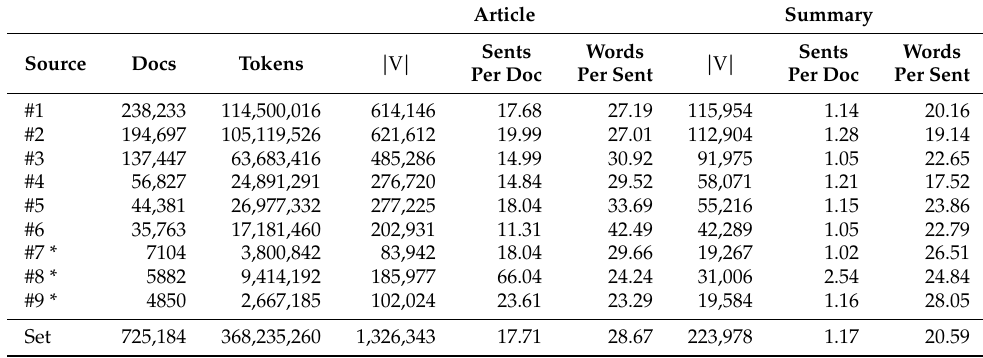
Table 1. Statistics of Catalan set. Sources marked with * were not used for training the